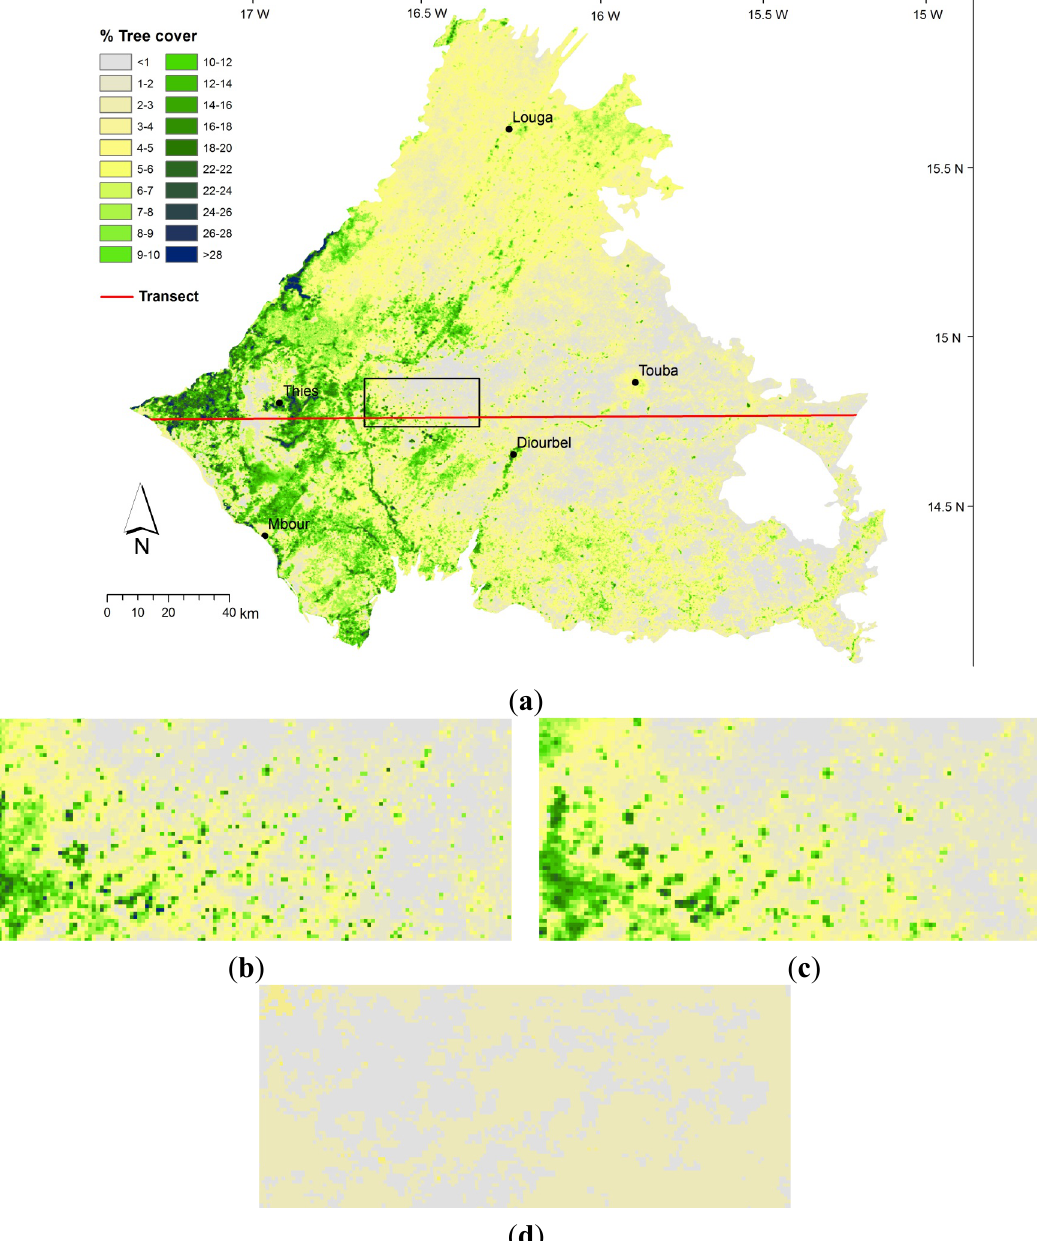
Figure 6. Map of model estimated tree cover in the west central agricultural region of Senegal ( a ) Enlarged area shows reference tree cover, ( b ) modeled tree cover ( c ) and MODIS Vegetation Continuous Fields (VCF) product (Collection 5) of 2008 for the same area ( d ). The 2008 VCF product was chosen for display, because the VCF quality layers indicate that it is the best of the available 11 years of VCF data for this area. Reference and modeled tree cover range from 0 to 22%, whereas the VCF tree cover ranges from 0 to